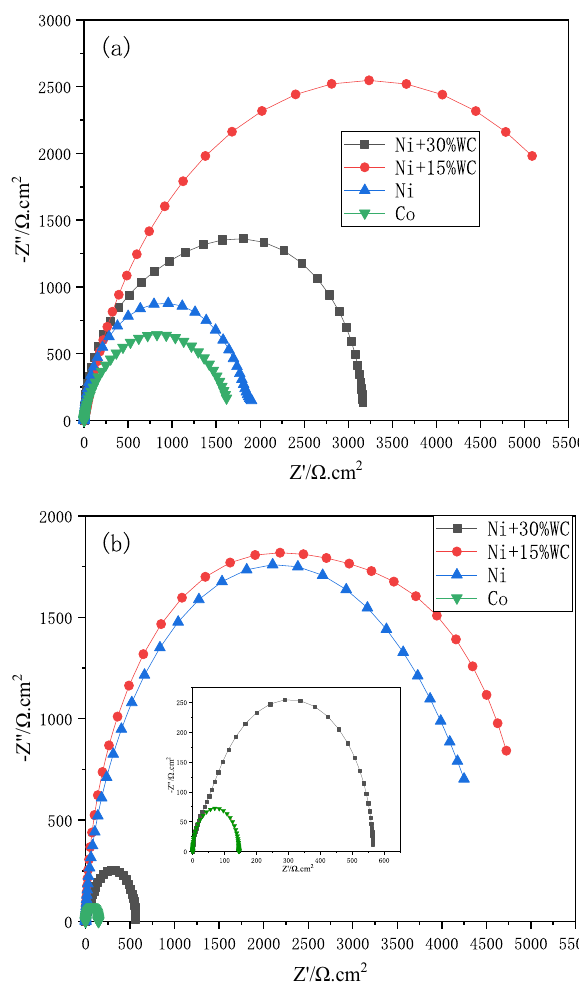
Figure 5: Nyquist plots of di ff erent coatings in the 0.5 mol · L − 1 HCl solution ( a ) and 3.5 wt% NaCl solution ( b ) for 120